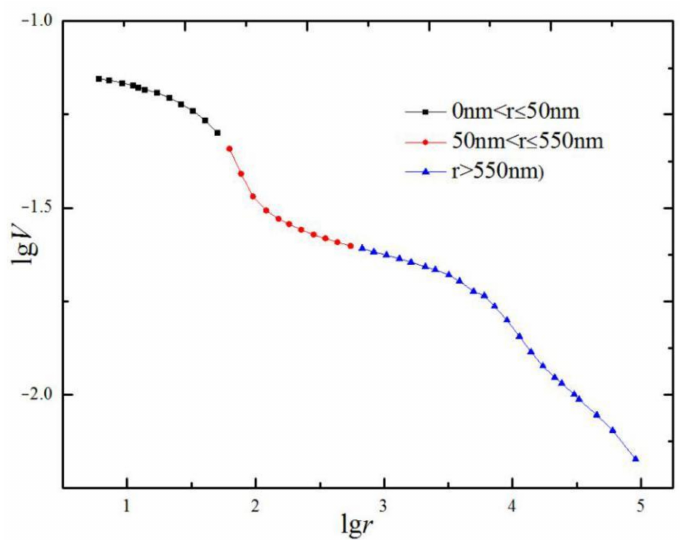
Figure 10. Relationship between Lg r and Lg V of slag concrete.